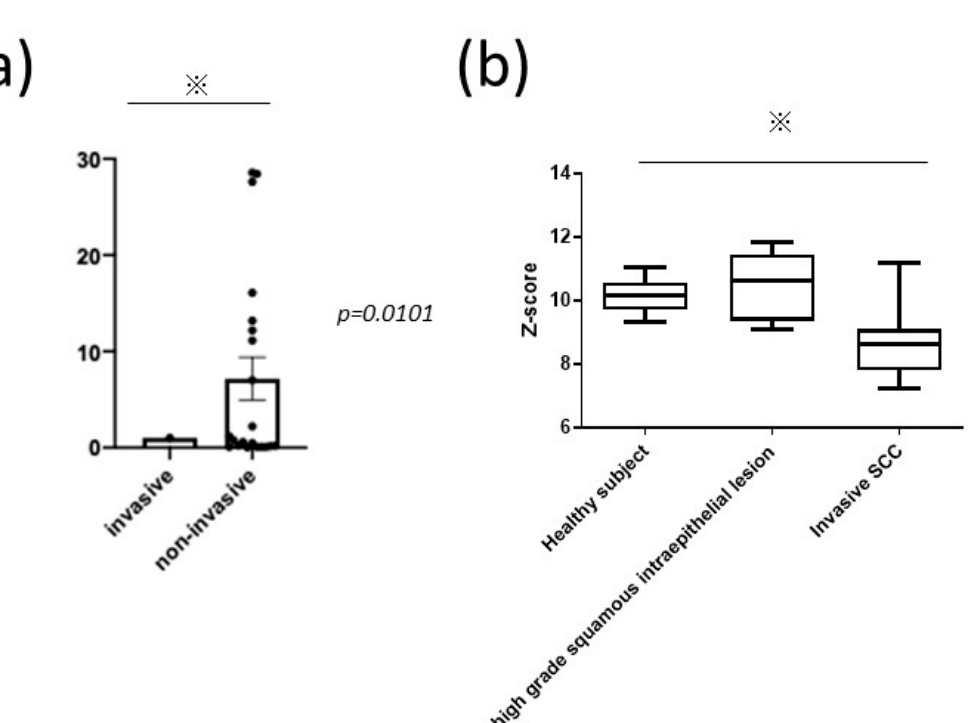
Figure 3. Gene expression of CADM1 and microarray dataset analysis. ( a ) Difference in CADM1 gene expression between non-metastatic and metastatic cSCC patients. ( b ) Microarray analysis using a previously published dataset. The p -value was evaluated by a Student’s t -test and one-way ANOVA. * indicates a statistical significant difference.